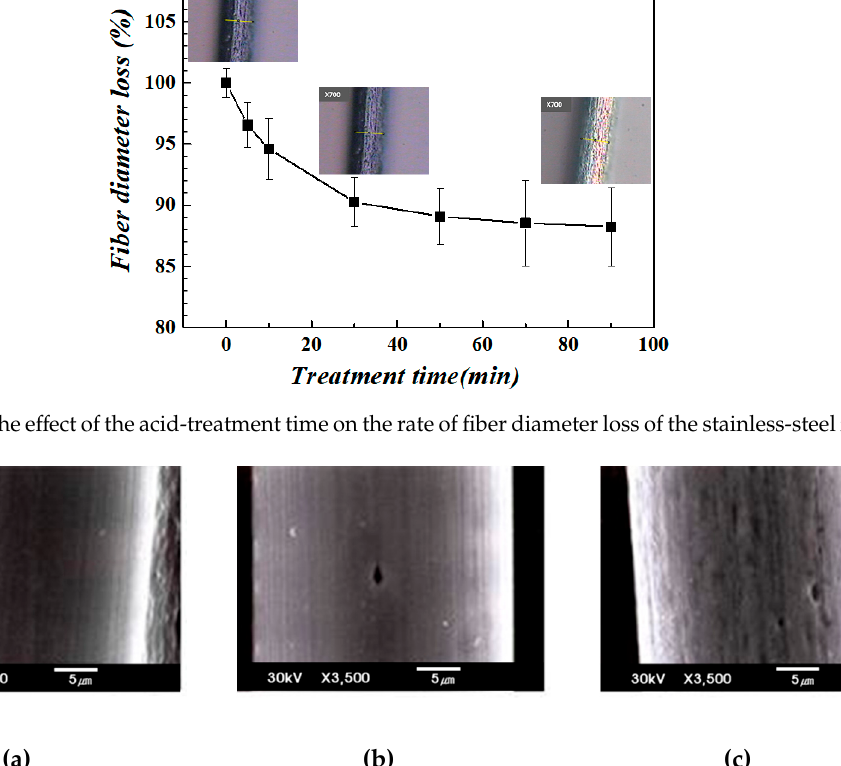
Figure 4. Photographs (700 X) of the stainless-steel fiber (a) without the acid treatment and after (b)